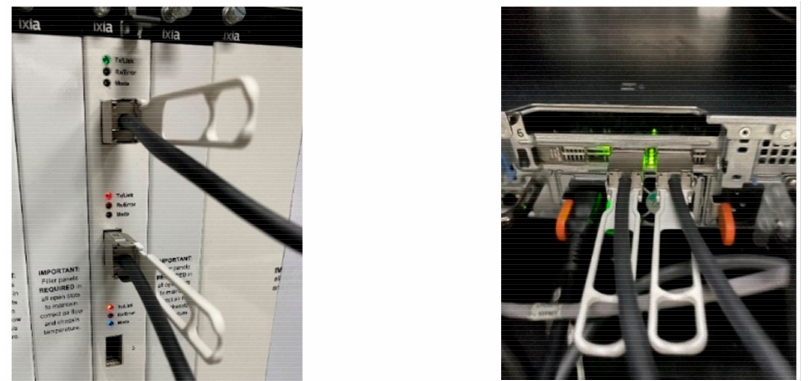
Figure 18. Hardware setup.